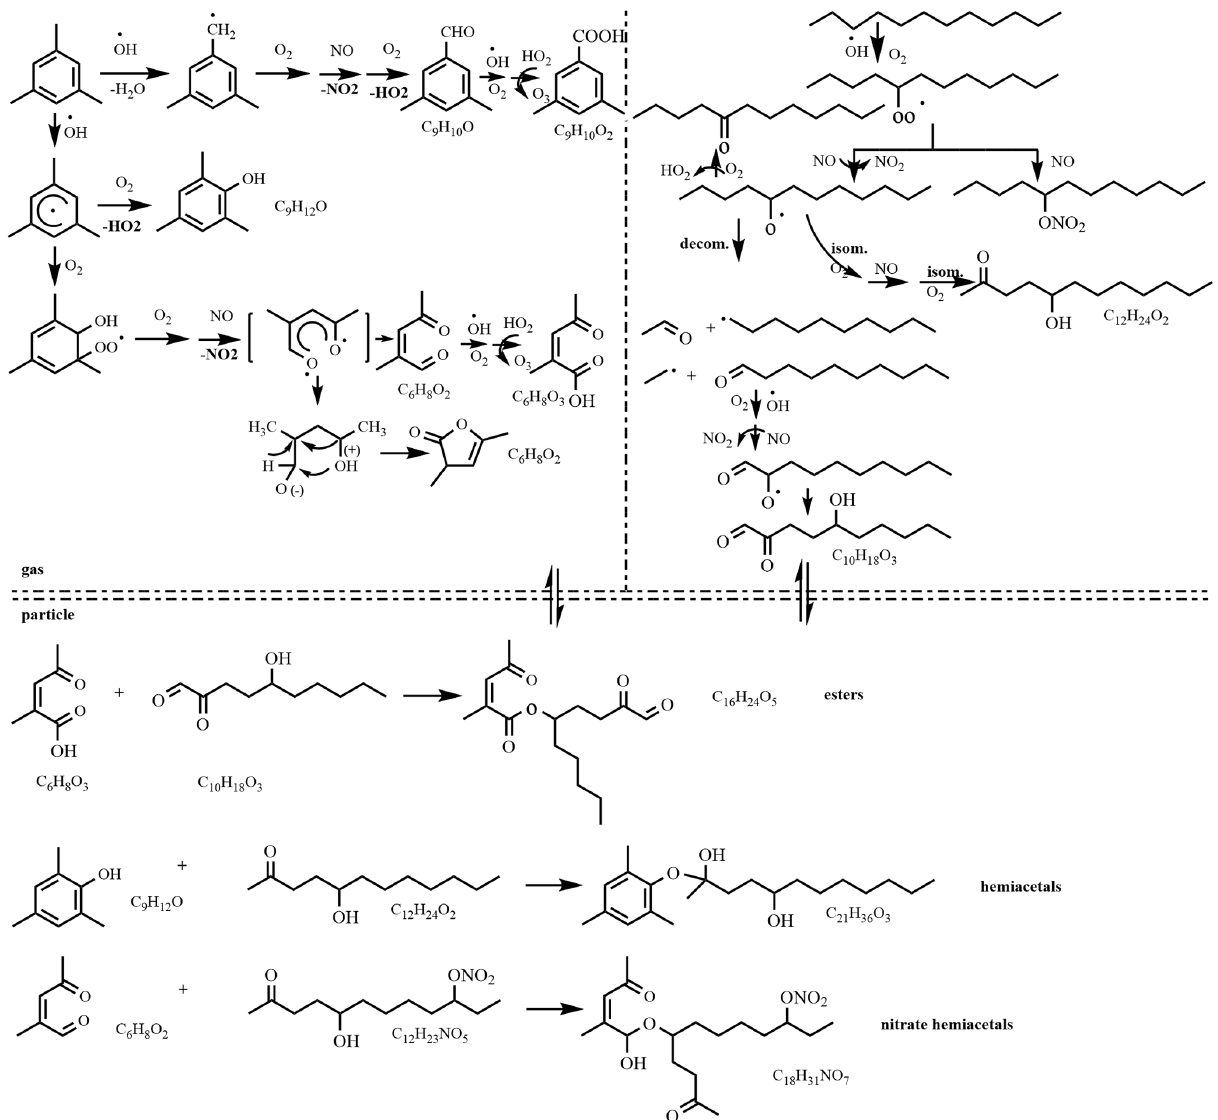
Figure 5. Proposed reaction mechanism of the mixed AVOC system in the presence of NO x (R1 and R2 are alkyl groups or aromatic hydrocarbon